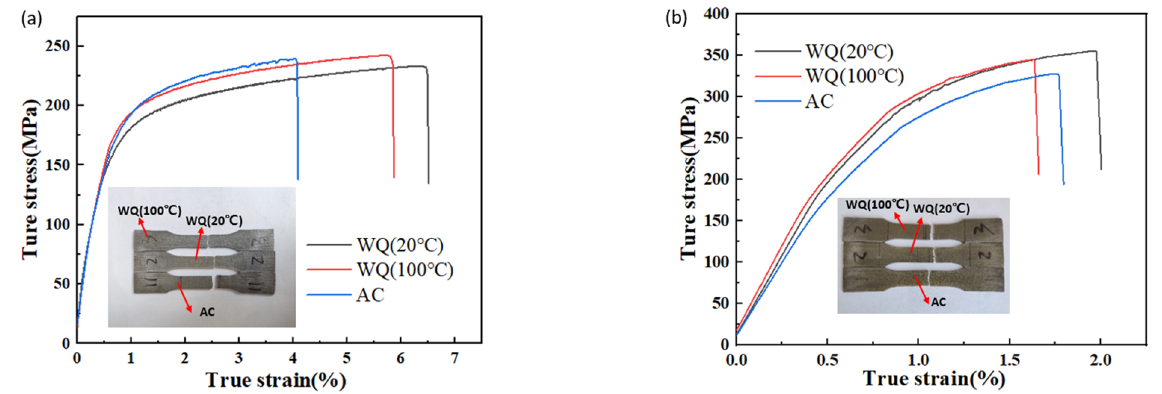
Figure 14. Stress–strain curves and fractured location of the tensile specimens in ( a ) quenching state and ( b ) aging state.